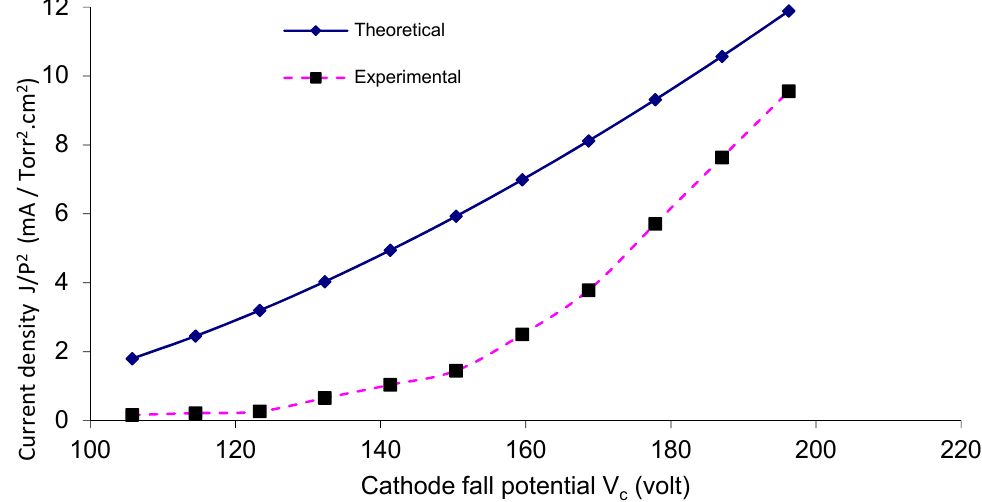
Figure 7. Current density as a function of the cathode fall potential for OMTSE with applied pressure of 1 mTorr.